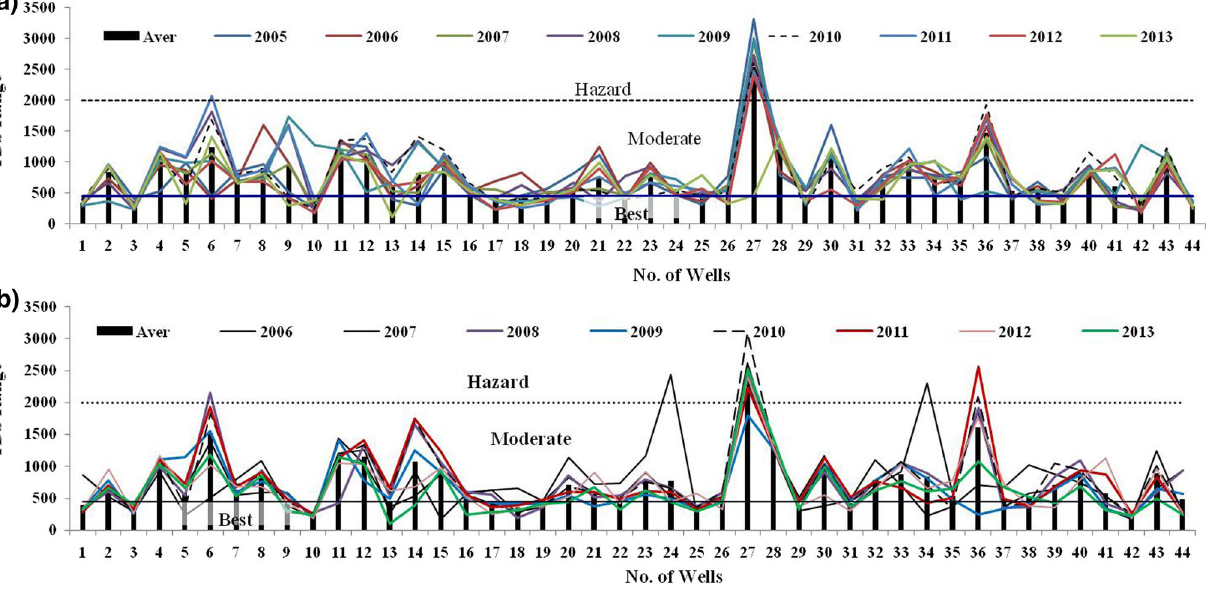
Fig. 12 a Nine-year (2005–2013) temporal representation of TDS value during pre-monsoon. b Nine-year (2006–2013) temporal representation of TDS value during